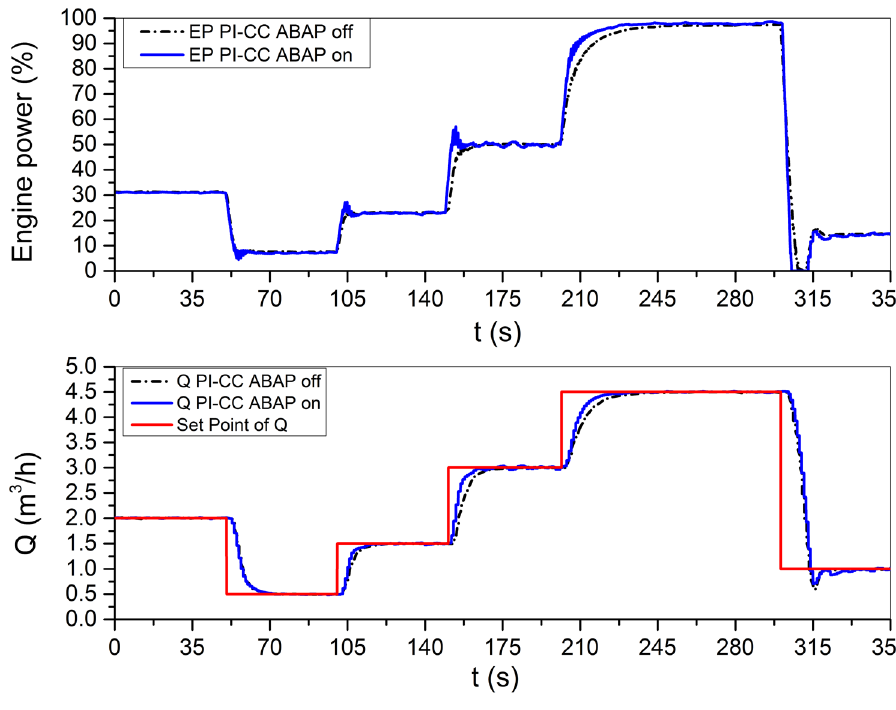
Fig. 11 Flow rate and pump power in function of time dur- ing test of disturbance rejection with auto-tuning feature